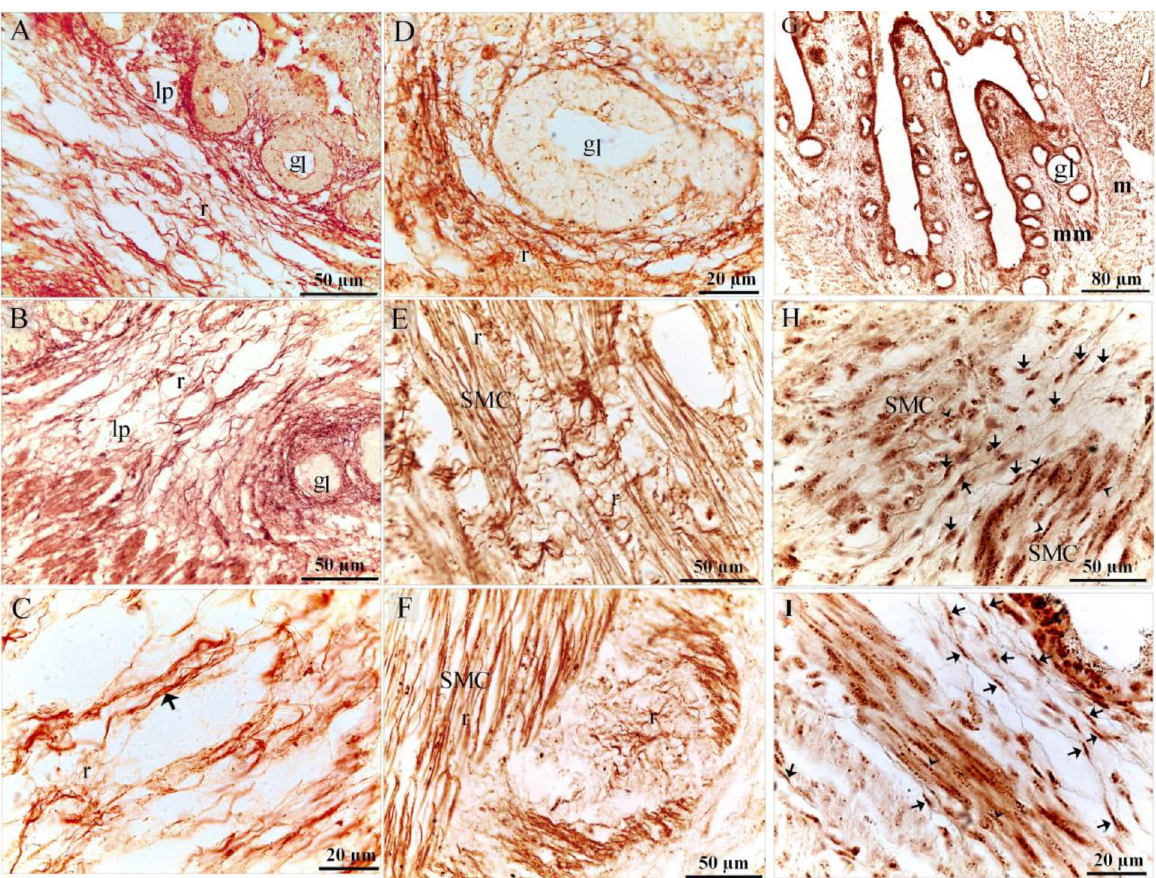
Figure 4. Detection of the reticular fibers using Gomori’s silver stain. Cross section of day 15 of quail embryo stained with Gomori’s silver stain ( A – F ) and Bielschowsky’s silver stain ( G – I ). ( A , B ) reticular fibers (r) in the lamina propria (lp). Note gland (gl). ( C ) telocyte (arrow) located in the LP. Note reticular fibers (r). ( D ) Reticular fibers (r) surrounded the gland (gl). ( E , F ) Reticular fibers (r) surrounded each cell of smooth muscle (SMC) and in the myenteric or Auerbach’s plexus. ( G – I ) Telocytes (arrows) between the muscle bundles (SMC). Note granular appearance indicating dense bodies